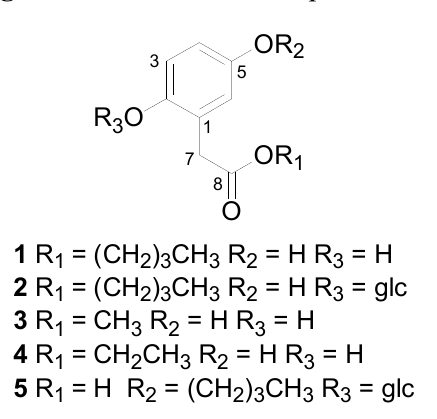
Figure 1. Structures of compounds 1 – 5 .